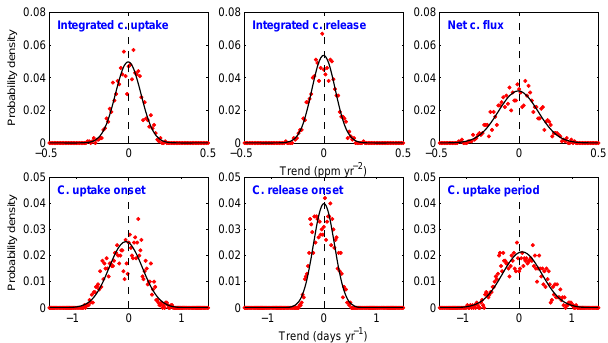
Figure B6. Probability densities of trends introduced as part of a 1000-member ensemble of synthetic time series generated for the Monte Carlo experiment where the black line is the fitted probabil- ity